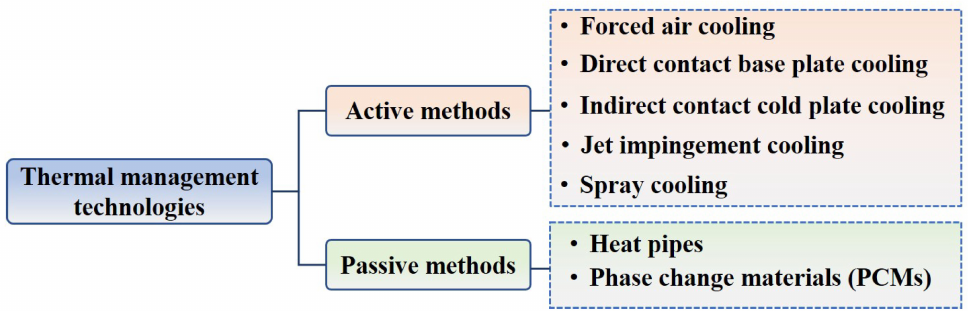
Figure 3. Thermal management technologies applicable for electronics on board automobiles and aircraft.